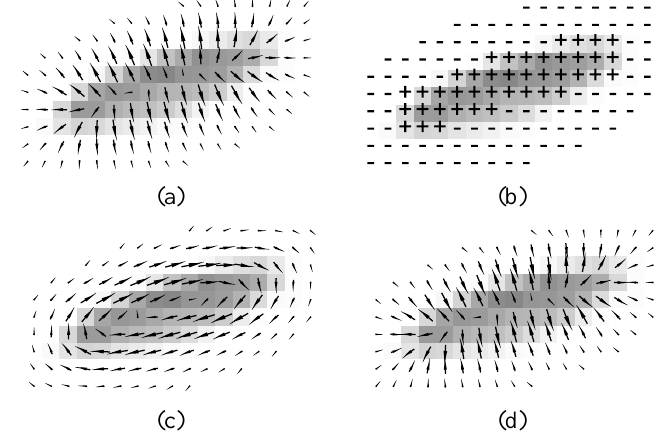
Figure 1. ( a ) ∇ P , ( b ) ∇ 2 P , ( c ) an edge vector field (cid:126) e , and ( d ) a normal compressive vector field (cid:126) n